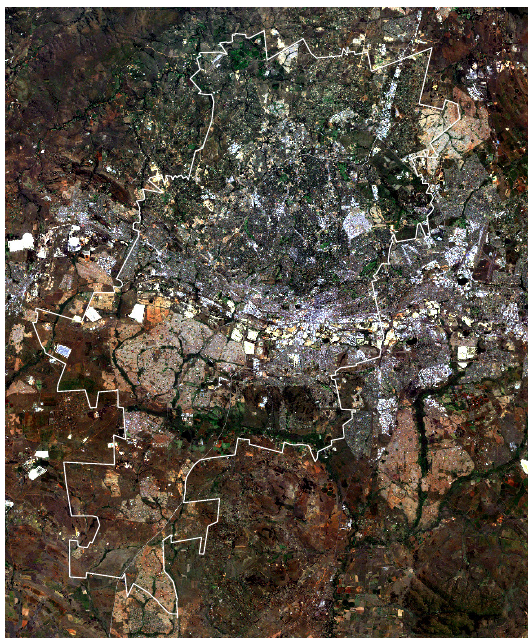
Figure 2: Landsat 7 image (15 March 2003) of the study area. The white boundary line indicates the extent of Greater Johan- nesburg Metropolitan area. The study area is centred over the Johannesburg